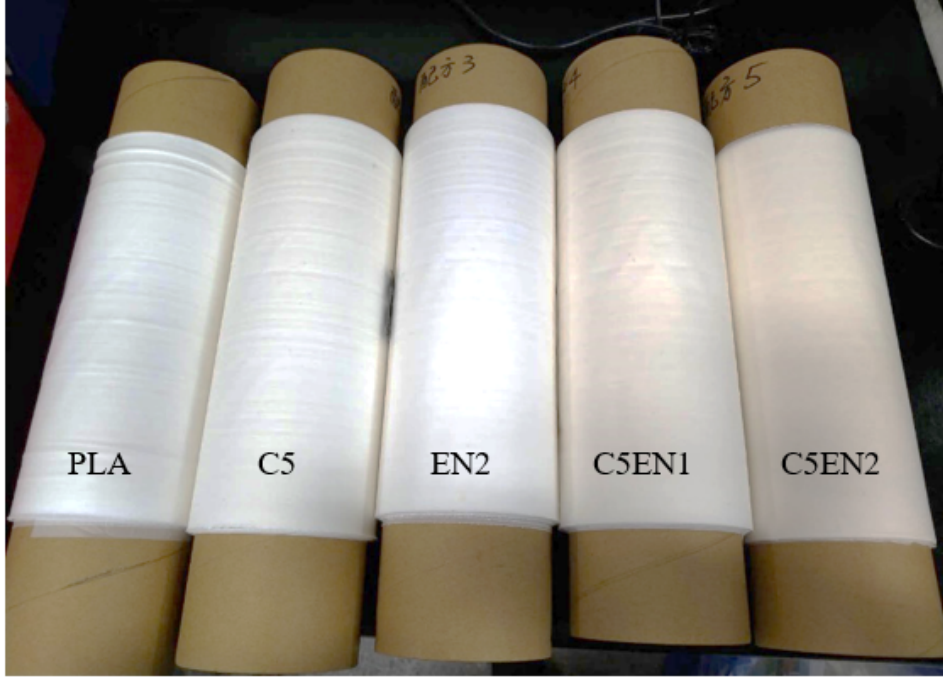
Figure 2. Appearance of PLA, C5, EN2, C5EN1, and C5EN2 films. (Film thickness: 30 µm). Table 1. Tensile strength, elongation at break, and tearing strength of PLA, EN2, C5, C5EN1, and C5EN2